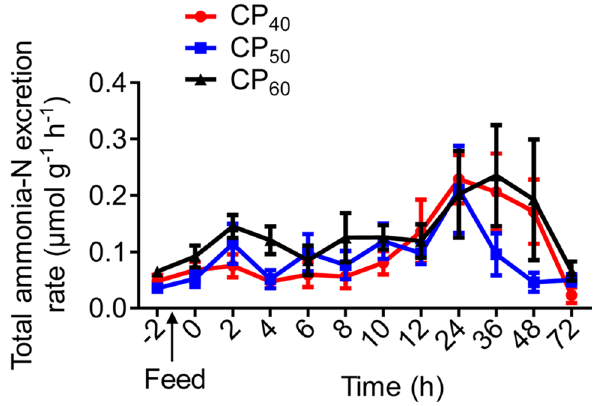
Figure 2. Total ammonia-N excretion rate ( M TAN, μmol g −1 h −1 ) in juvenile Sagmariasus verreauxi . Lobsters were reared at 21 °C and fed 15 N-labeled feeds at 1.5% body weight at three crude protein levels: 40%, 50% and 60%, corresponding to CP 40 , CP 50 and CP 60 treatments, respectively. The M TAN at − 2 h indicates the routine M TAN. The first post-prandial M TAN was recorded at 0 h. All data represent mean ± standard error (SE) of 6 individuals.